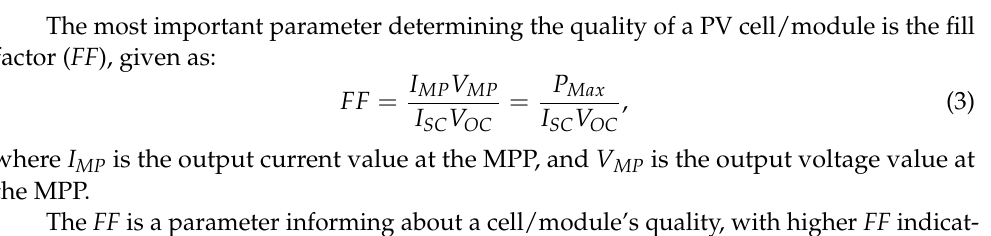
( b ) Figure 3. Effect of parasitic resistances R s and R sh on the I – V characteristics ’ shape: ( a ) Effect of series resistance R s for the MPP – V OC slope; ( b ) Effect of shunt resistance R sh for the MPP – I SC slope.